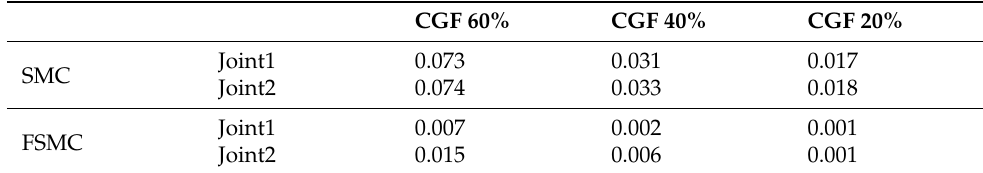
Table 1. Maximum errors (rad) at steady state.